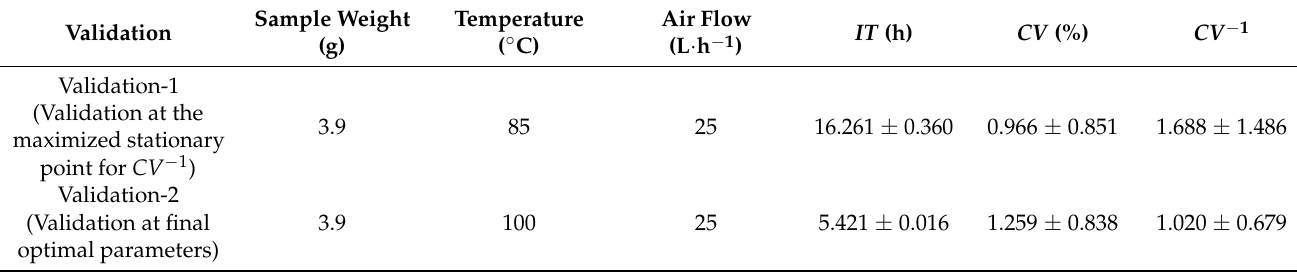
Table 5. Mean and standard deviation of the IT (h), CV (%), and CV − 1 obtained from the validation of operational parameters at the stationary point (Validation-1) and optimal parameters